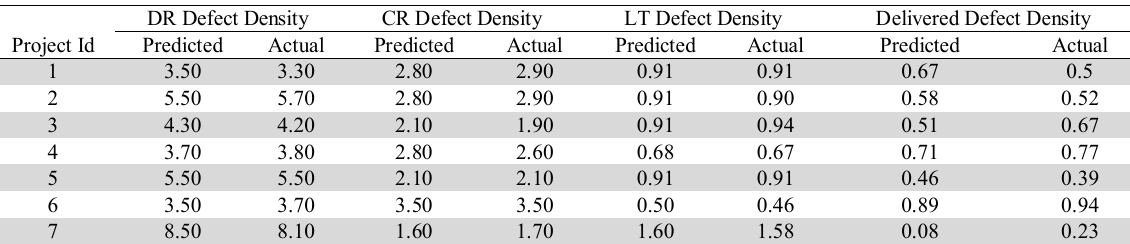
Validation results Project